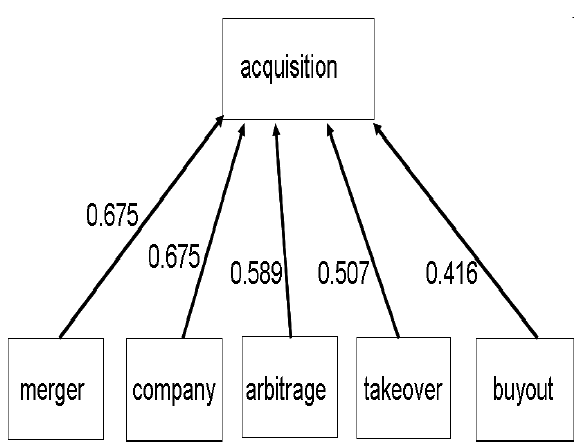
Fig. 2. The Representation of the Concept